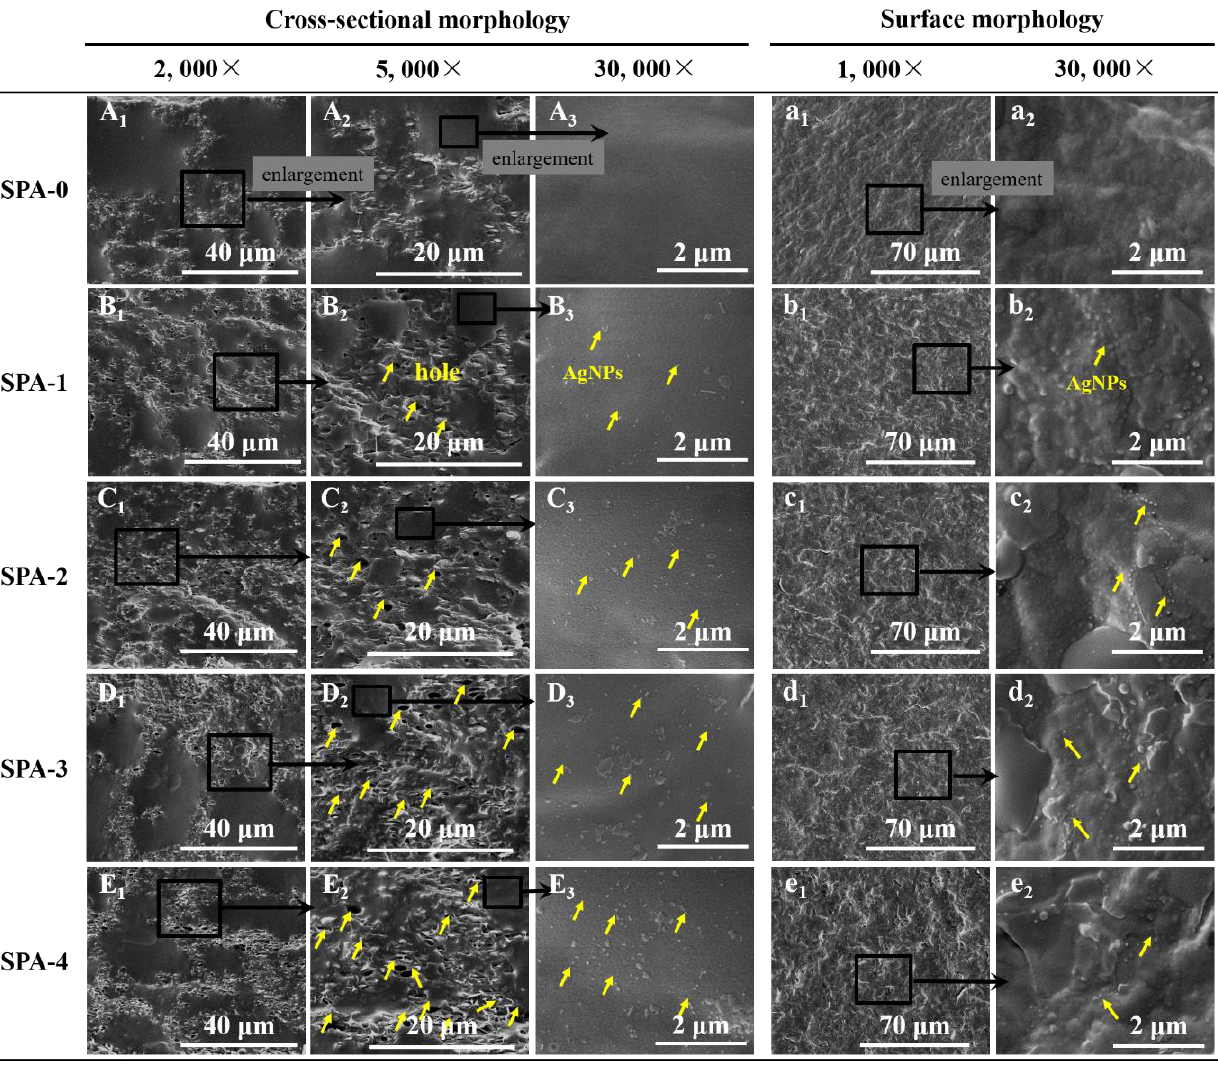
Figure 2. SEM images of starch/PBAT antibacterial films loaded with different levels of AgNPs@SiO 2 .